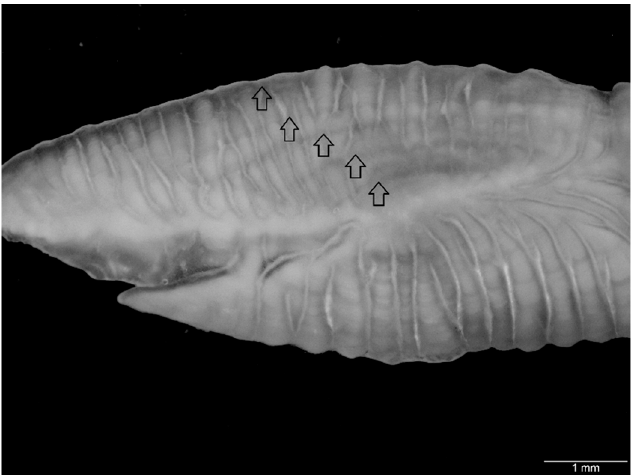
Figure 2. Sagittal otolith of the 5 year old European barracuda, Sphyraena sphyraena , in the eastern Adriatic.